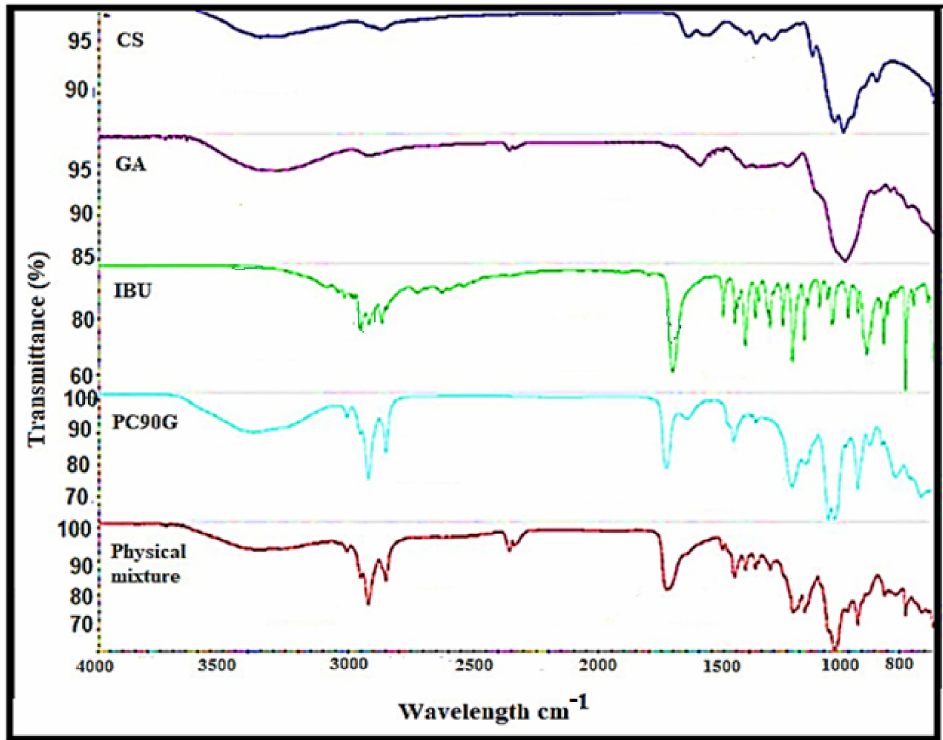
Figure 2. FTIR spectra of chitosan (CS), gum arabic (GA), pure ibuprofen (IBU), PC90G (lipid) and physical